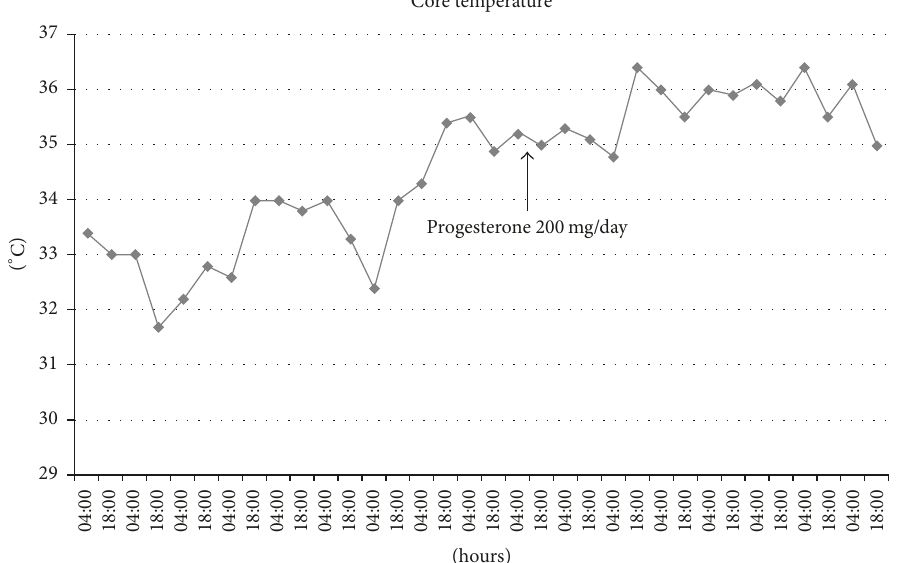
Figure 3: Core temperature recorded from a central venous catheter twice a day (4:00 and 18:00), before and after the introduction of oral